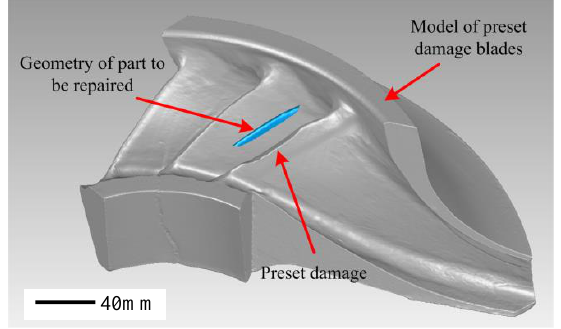
Figure 9. Schematic diagram of fill holes and gaps. J. Manuf. Mater. Process. 2018 , 2 , x FOR PEER REVIEW